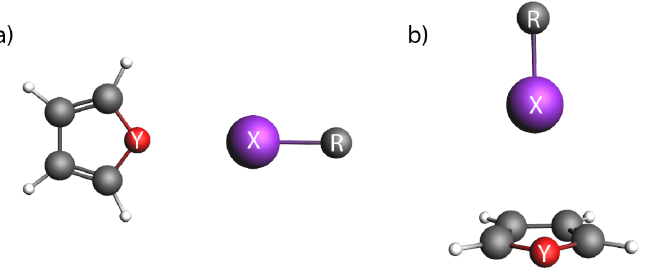
Figure 1. Schematic Yes you can move it. representation of geometries in ( a ) parallel ( (cid:107) ), and ( b ) perpendicular ( ⊥ ) orientation. X = Cl, Br, I; Y = O, S, Se; R = CF 3 , C 2 F 3